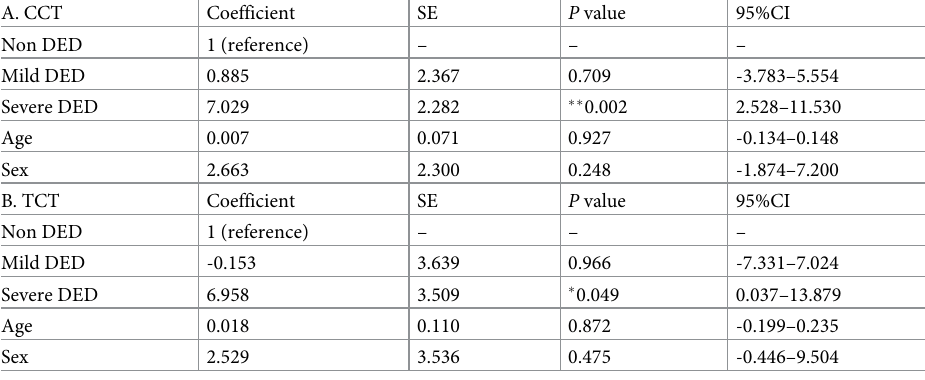
Table 3. Adjusted CCT and TCT differences between Pentacam and ASOCT.